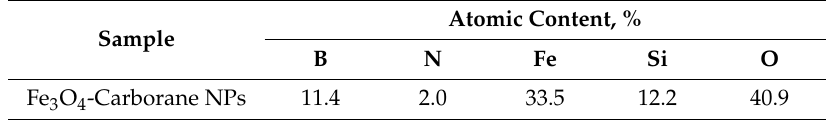
Table 3. Element ratio variations by using the EDX method of Fe 3 O 4 nanoparticles with